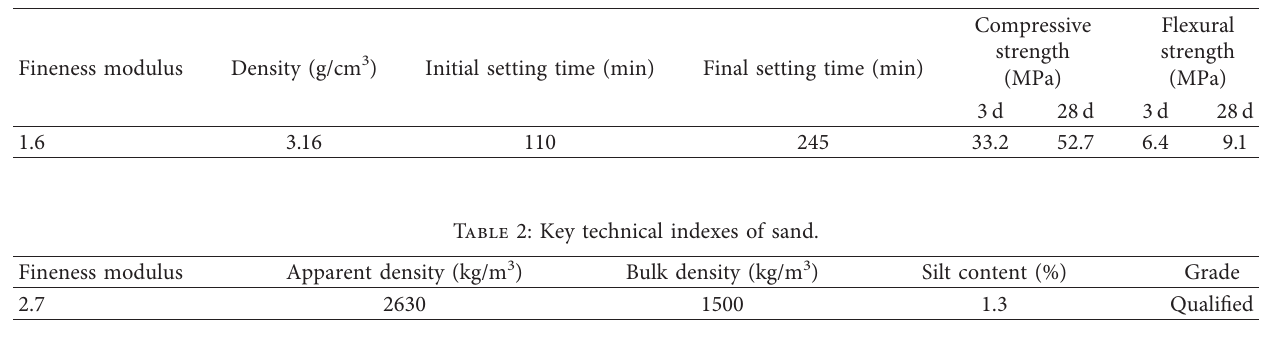
Table 1: Main performance indexes of cement.